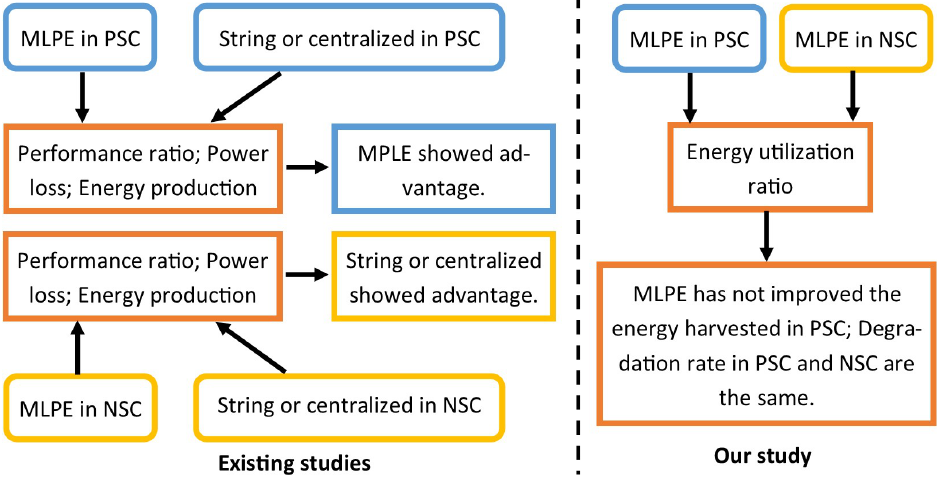
Figure 8. The comparison between existing studies in literature and our study